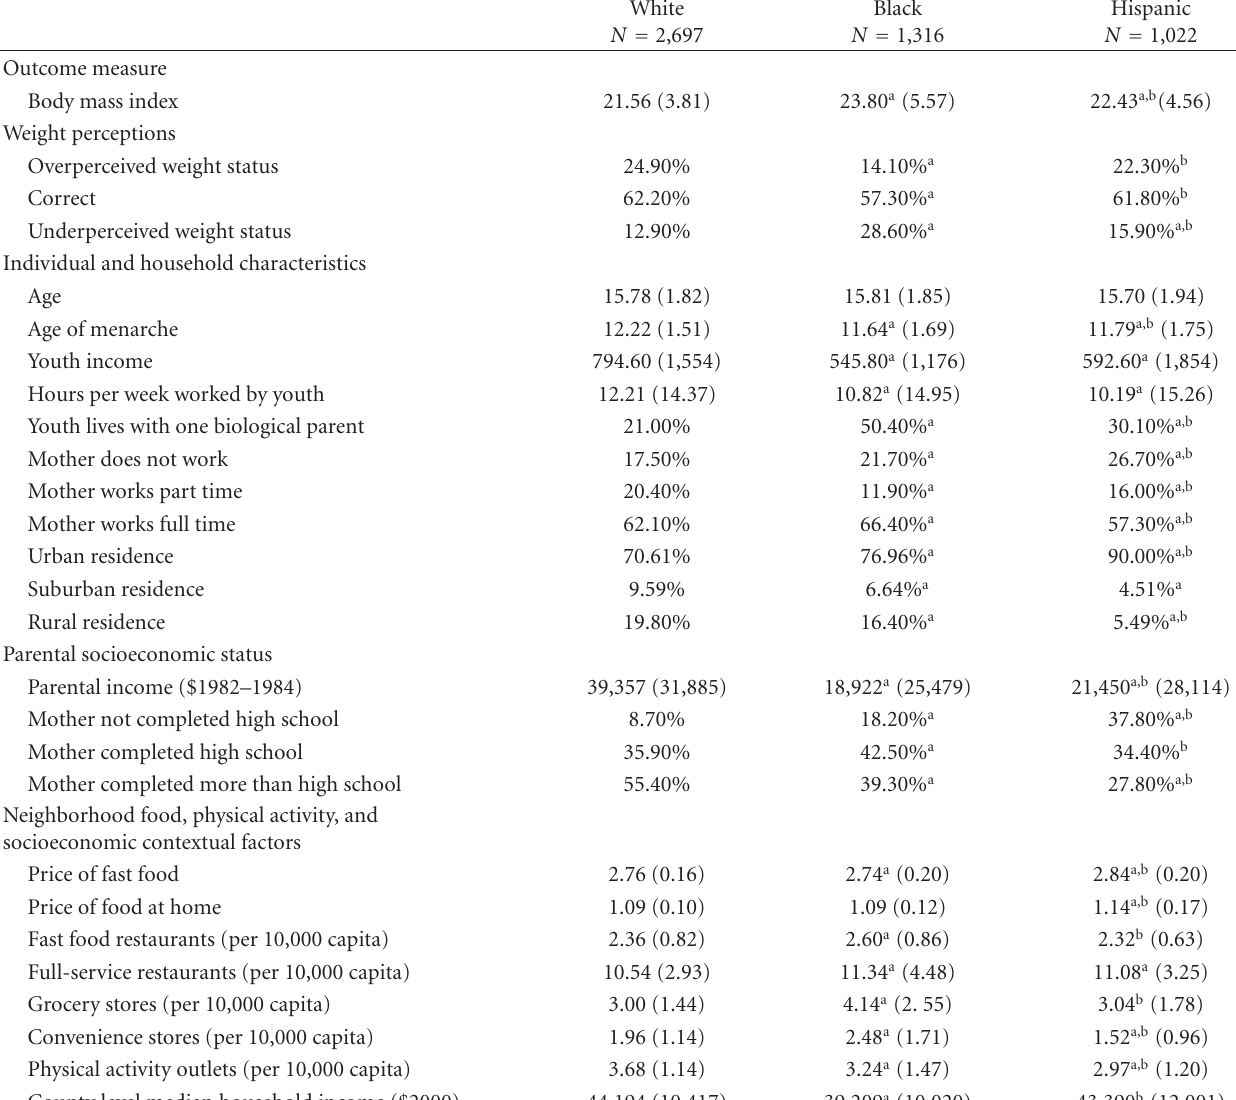
Table 1: Summary statistics: means (SD) and